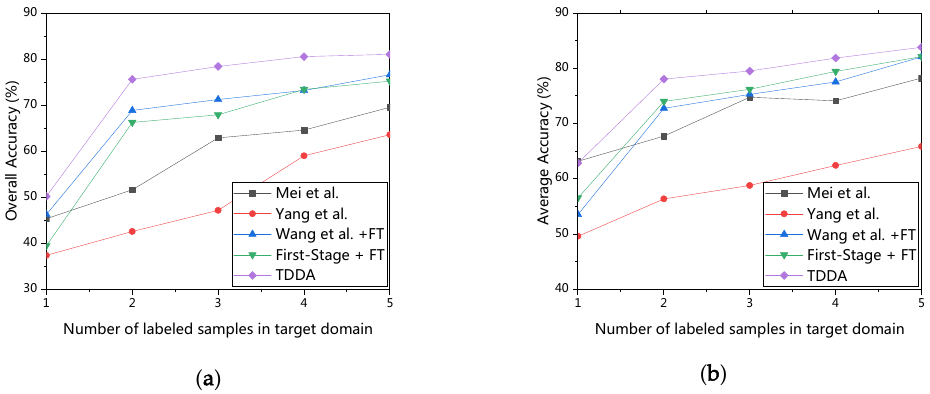
Figure 11. The classification results of different methods with different labeled samples in target domain on Pavia Center → Pavia University dataset. (a) OA. (b) AA.